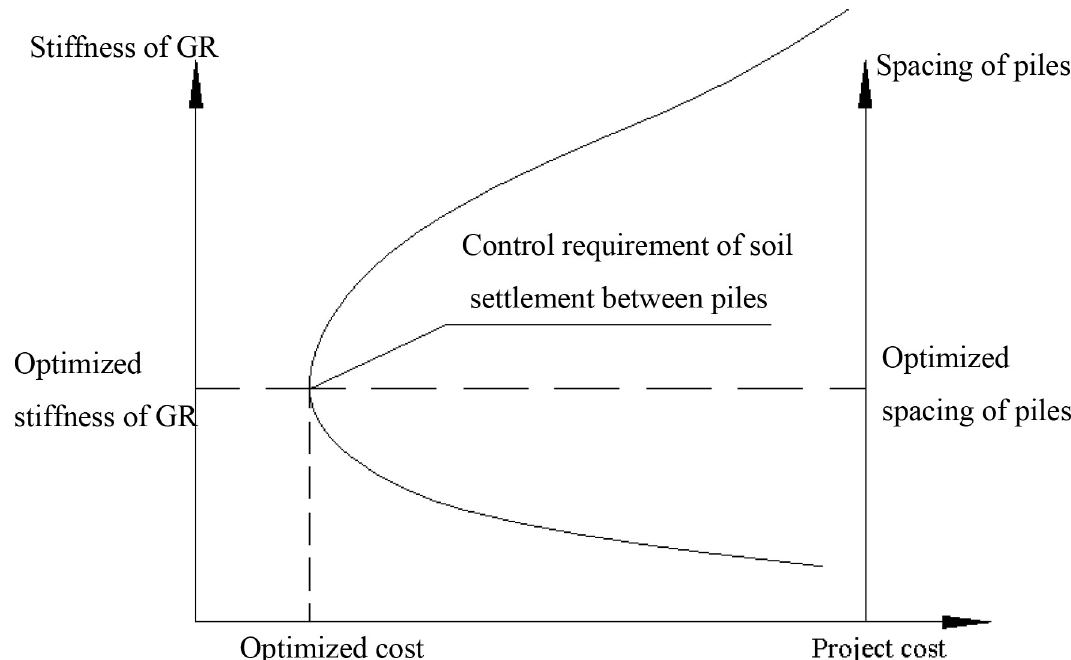
Fig 4. The schematic diagram showing the optimization principle in this